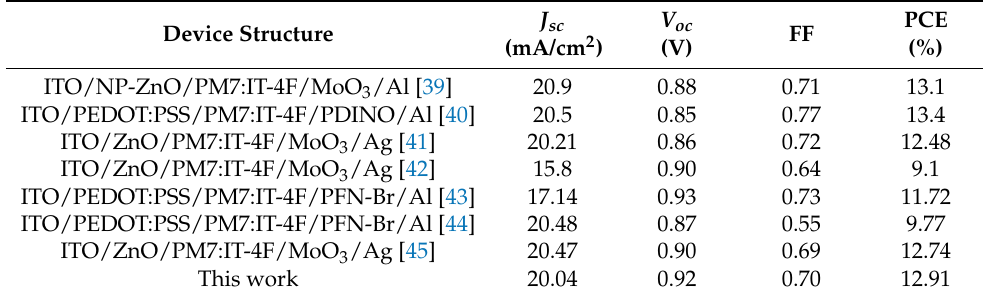
Table 2. Photovoltaic parameters of devices in relevant